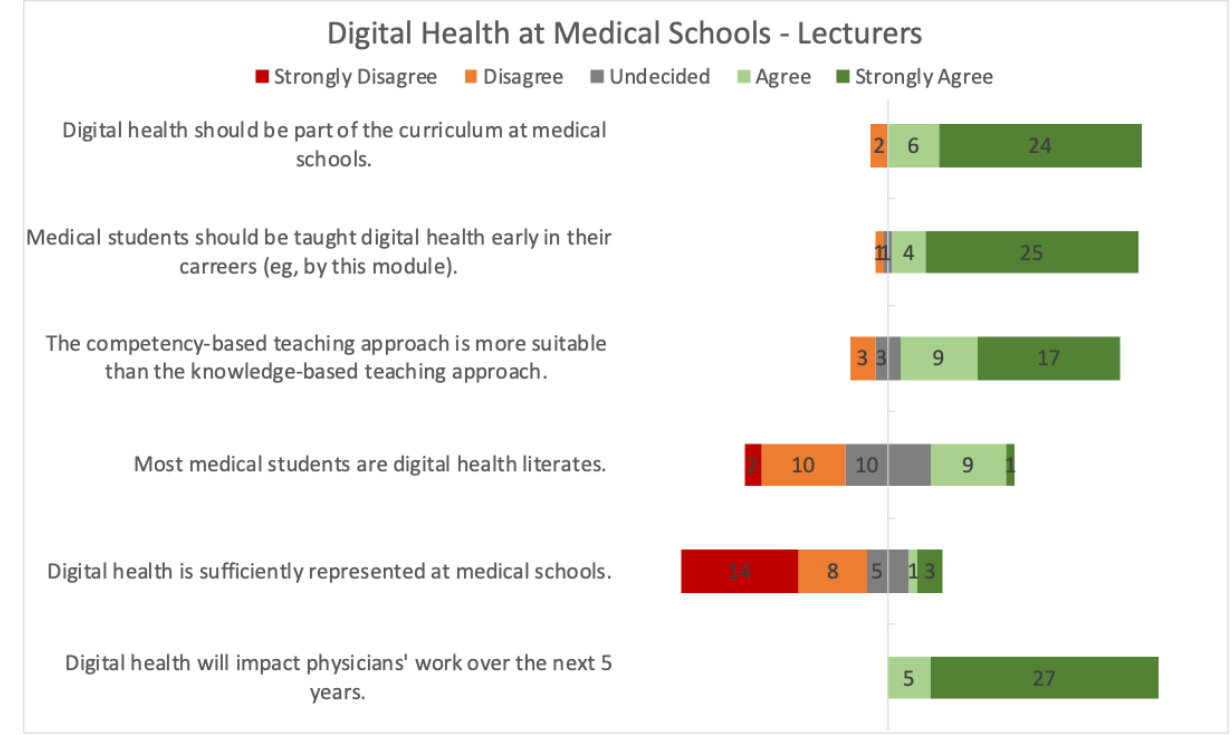
Figure 4. Lecturers’opinions regarding digital health at medical